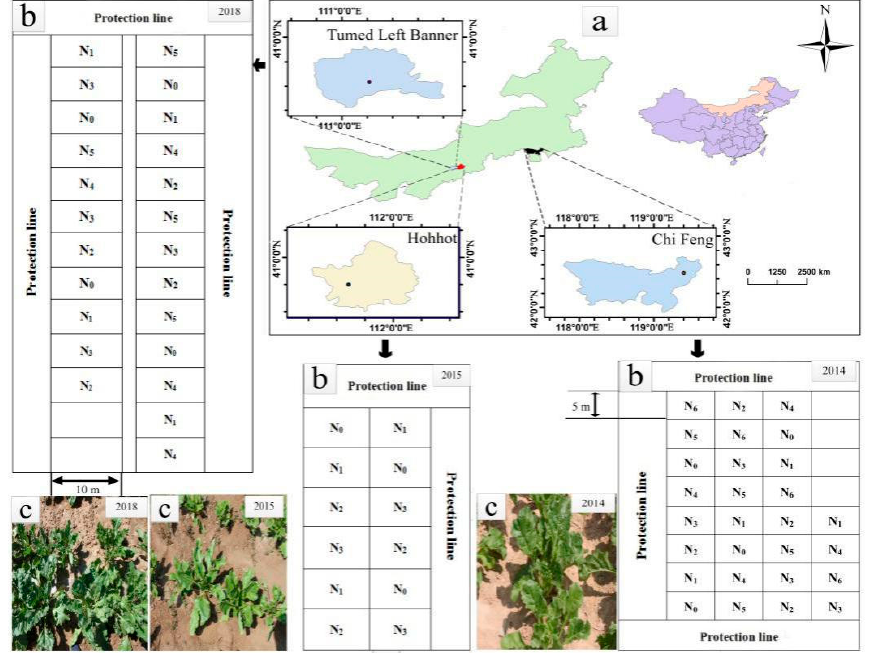
Figure 1. Location of the study sites ( a ), experimental layout showing plots (5 m by 10 m), different levels of nitrogen fertilizer (e.g., N 0 , N 1 , N 2 , N 3 , N 4 , N 5 and N 6 ) applied ( b ) and photographs of sugar beet plants in 2014, 2015 and 2018 experiments ( c ).